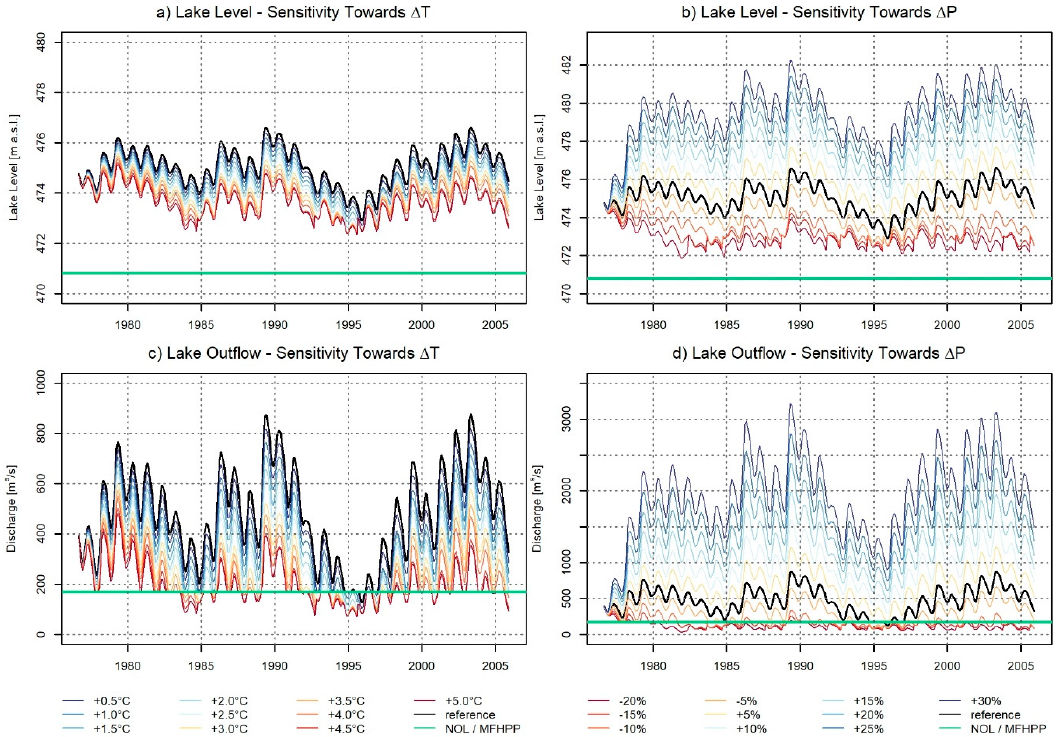
Figure 6. The sensitivity of lake level ( a and b ) and outflow ( c and d ) to systematical changes in temperature with constant P o (column 1) and precipitation with constant T o (column 2) based on Equations (8) and (9). Green lines in a and b mark the effective lake level of 470.8 m a.s.l. (i.e., No Outflow Level, NOL), while in c and d, green lines mark the flow required for maximum hydropower generation (170 m³/s) (i.e., Maximum Flow For Hydropower Productivity, MFHPP). Black curves in each plot mark the reference simulations (i.e., with no changes in T and P ).